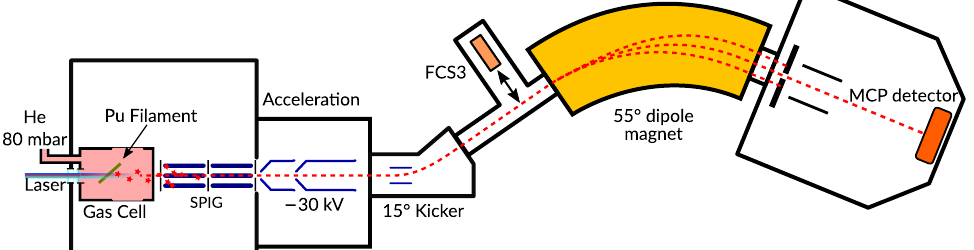
Figure 2. Schematic figure of the IGISOL beamline of relevance to this work. The gas cell is located inside the front-end vacuum chamber. Resonant laser ionization of plutonium atoms occurs along the gas cell axis; the ions are guided through a sextupole ion guide and accelerated towards the mass separator. The dipole magnet is set to mass-separate 244 Pu. An MCP detector in the separator focal plane is used to measure the ion counting rate. FC = Faraday